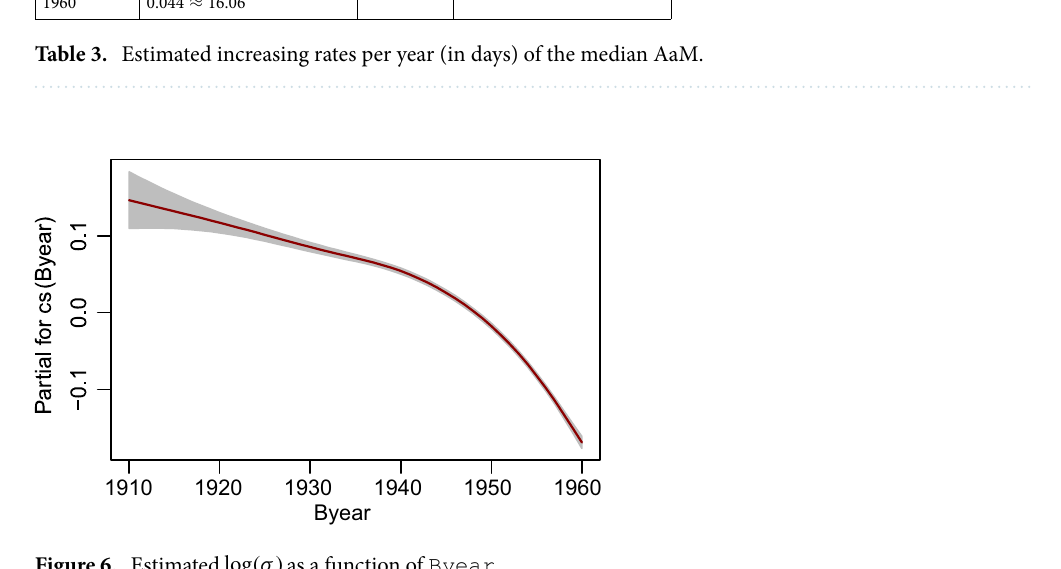
Figure 6. Estimated log (σ) as a function of Byear